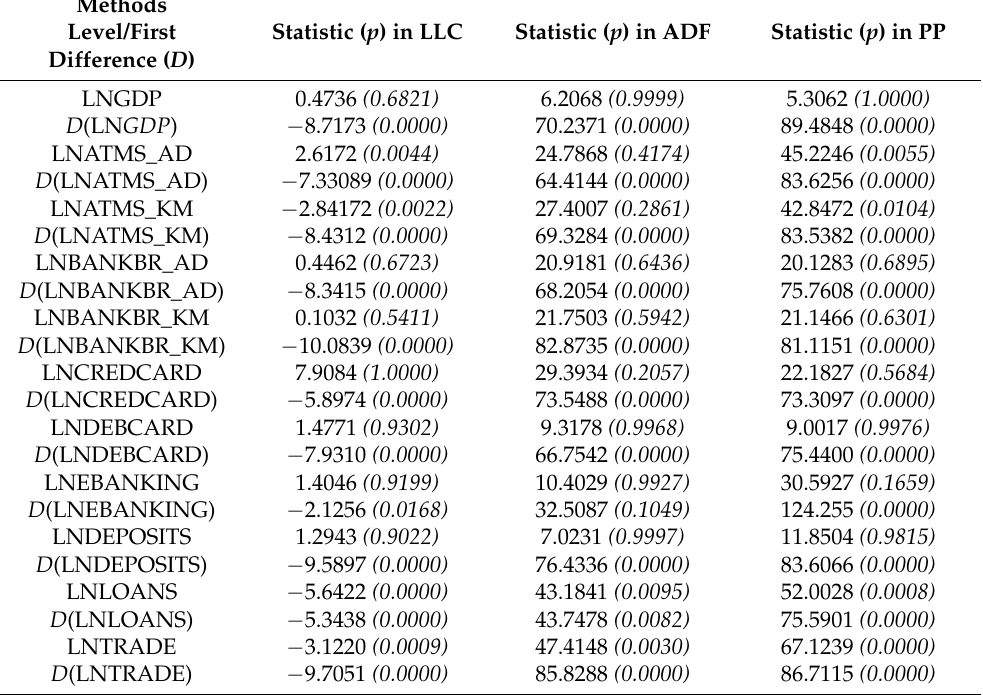
Table 4. Results for LLC unit root test, ADF—Fisher Chi-square and PP—Fisher Chi-square test.